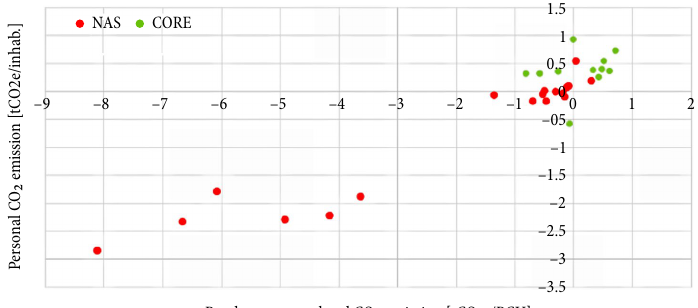
Fig. 7. Dynamics of personal and transport-related emission rates (please note that only 2000, 2005 and 2009 were